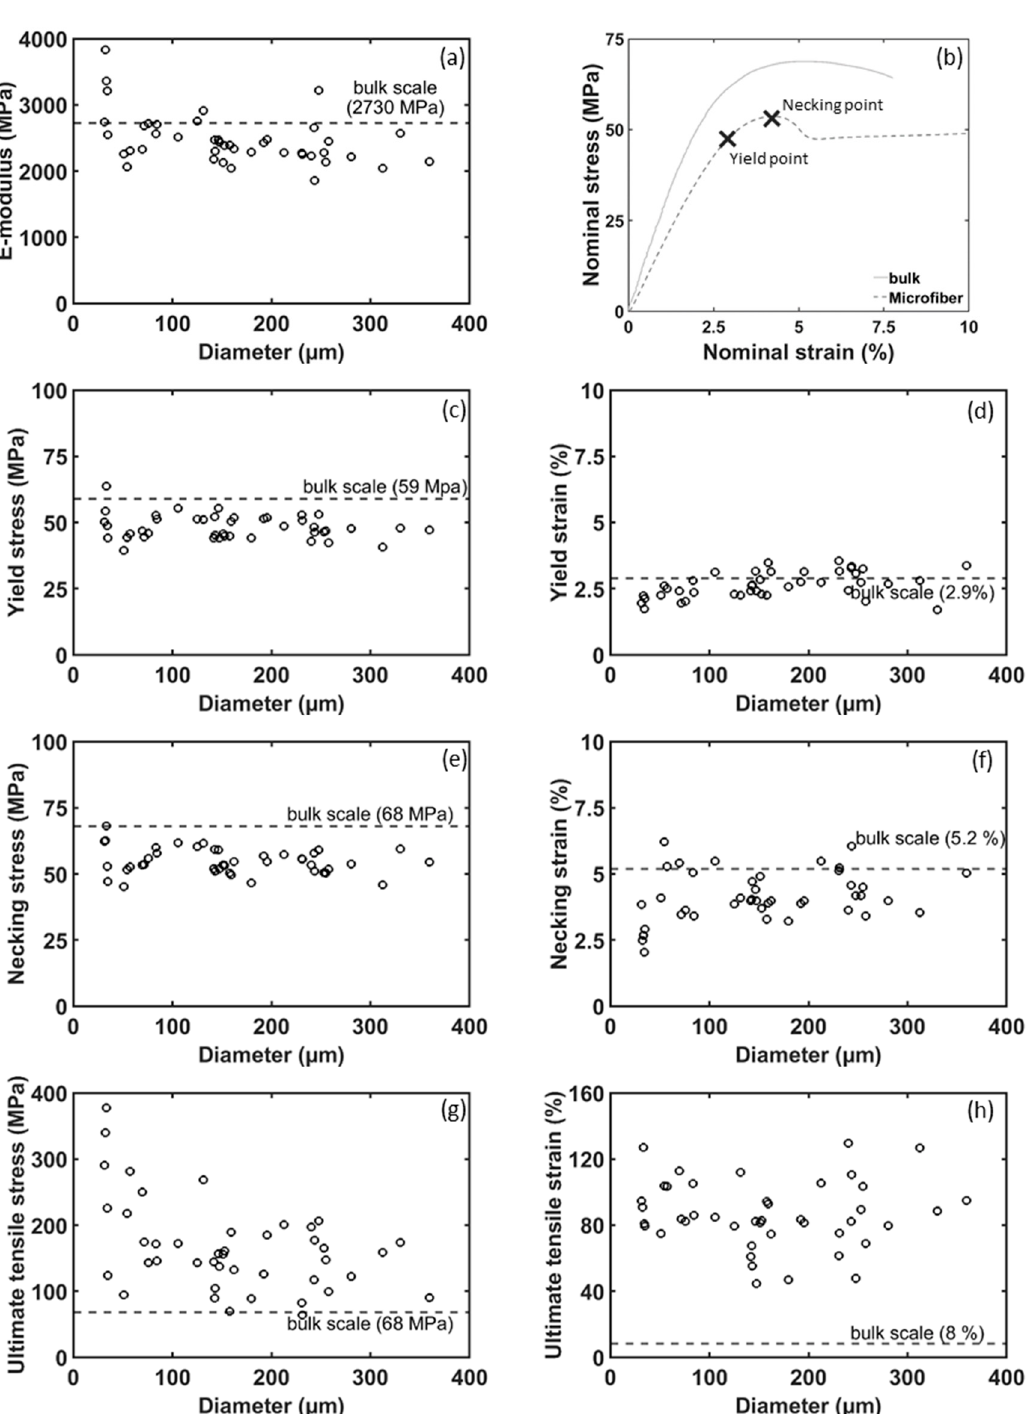
Figure 4. Representation of all mechanical data ( a ) E-modulus ( b ) engineering stress–engineering strain curve of representative microfiber tensile test with indication of necking and yield point ( c ) yield stress ( d ) yield strain ( e ) necking stress ( f ) necking strain ( g ) ultimate tensile stress and ( h ) ultimate tensile strain.